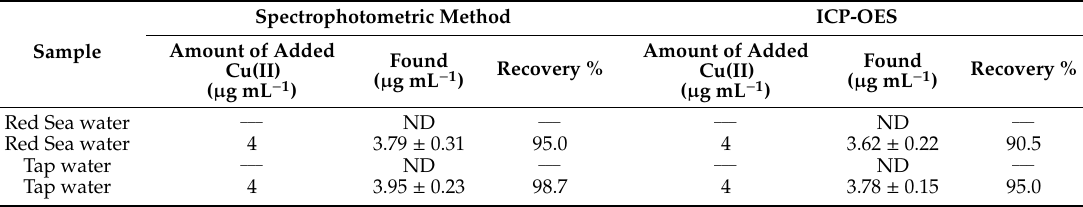
Table 7. Evaluation of proposed spectrophotometric method by determining copper in water samples